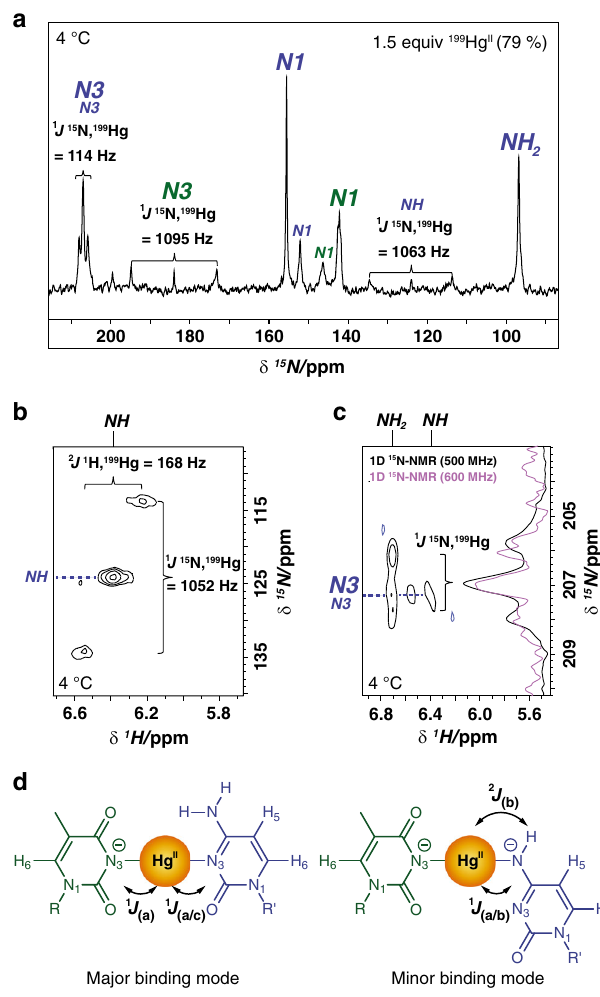
Fig. 4 Nucleobase-metal-nucleobase connectivity of C-Hg II -T base pairs. a 15 N NMR of ODN 1 * “ C*-T* ” in the presence of 1.5 equiv of 199 Hg-enriched Hg(ClO 4 ) 2 (79 % enriched see Supplementary Fig. 13). b 1 J 15 N, 199 Hg and 2 J 1 H, 199 Hg coupling according to [ 15 N, 1 H]-HSQC. For full spectra see Supplementary Fig. 12b. c 1 J 15 N, 199 Hg coupling between cytosine N3 major and 199 Hg observed in the band-selective, long-range [ 15 N, 1 H]-HSQC spectrum. For full spectrum see Supplementary Fig. 12c. d Summary of major- and minor coordination complexes in duplex DNA and the observed couplings. DNA samples contained 1 mM duplex DNA and 3 mM 199 Hg- enriched Hg(ClO 4 ) 2 . Blue labels indicate 15 N resonances of C* and green labels indicate 15 N resonances of T* = 168 Hz in the [ 15 N, 1 H]-HSQC (Fig. 4b), a value that was similar to reported 1 H, 199 Hg coupling across nitrogen in unrelated systems measured in d6 -DMSO or CDCl 3 58 – 60 .